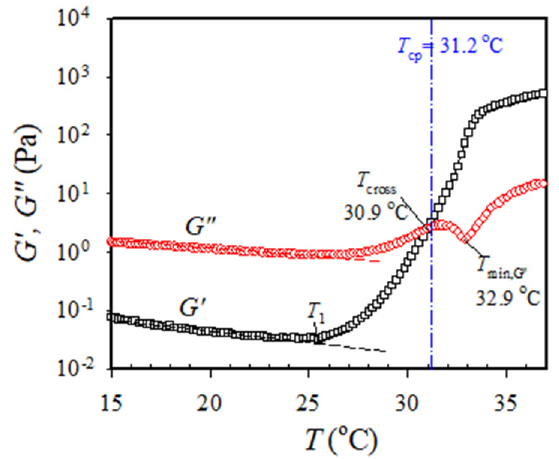
concentration fluctuations are developed at temperatures much below the cloud point of 31.2 ◦ C determined from the turbidity at 0.2 ◦ C/min heating as shown by the vertical dash–dot line.